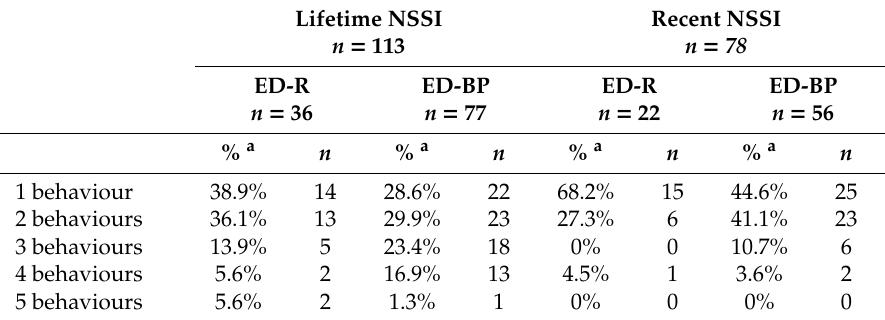
Table 1. The number of di ff erent lifetime and recent NSSI behaviours ED-R and ED-BP engaged in.